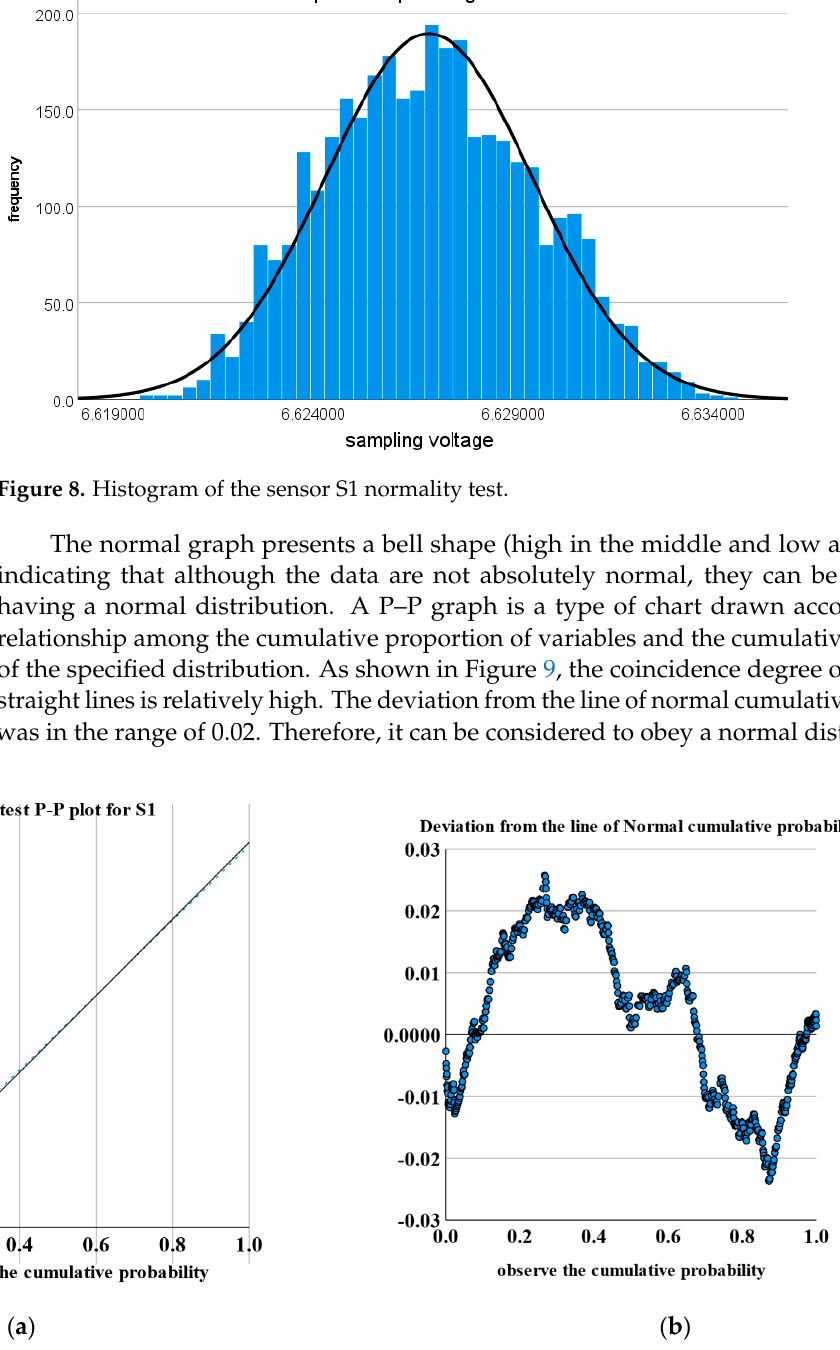
Figure 9. ( a ) P–P diagram of sensor S 1 . ( b )The deviation from the line of normal cumulative proba- bility.